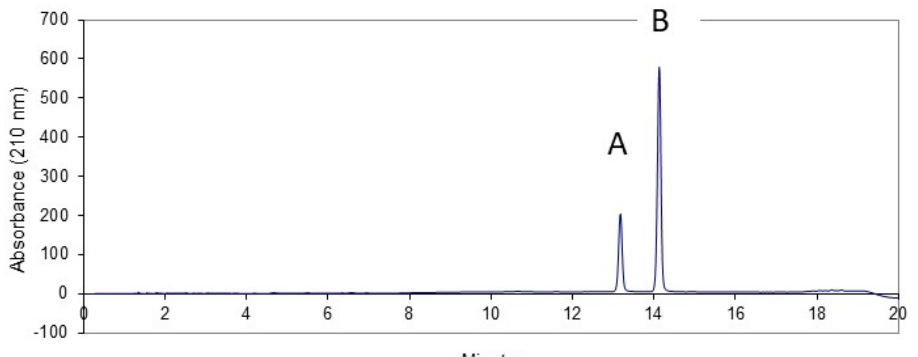
Figure 2. An RP HPLC analysis of the “echimidine” peak from E. plantagineum under buffer conditions (pH 6.8). Peak A—mixture of echihumiline and hydroxymyoscorpine. Peak B— echimidine.